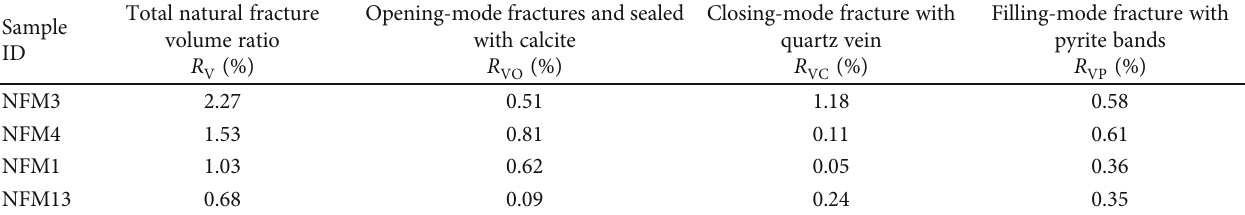
Figure 1: Typical marble samples containing natural fractures used in this work ((a – d) observation of the marble samples NFM3, NFM4, NFM1, and NFM13 from four directions of anterior, left, posterior, and right). Table 1: Statistical analysis of the natural fracture volume within the marble